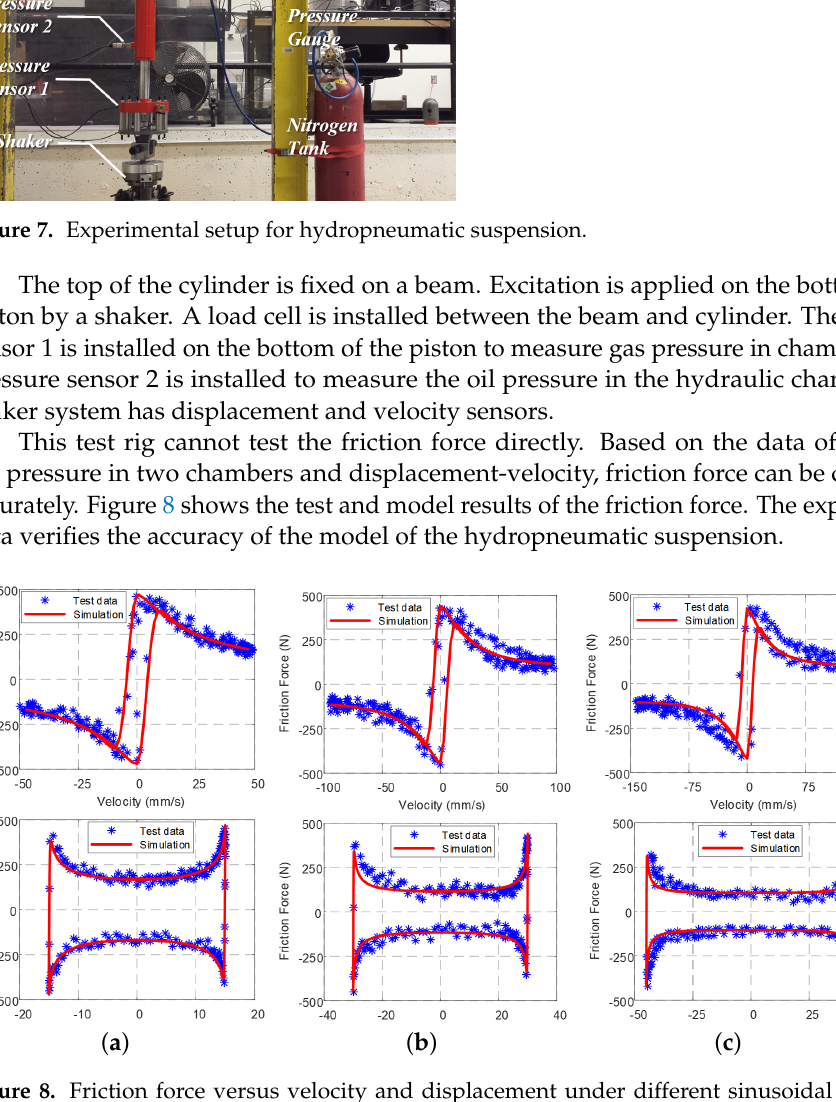
Figure 8. Friction force versus velocity and displacement under different sinusoidal amplitude ( a ) 0.5 Hz 15 mm ( b ) 0.5 Hz 30 mm ( c ) 0.5 Hz 45